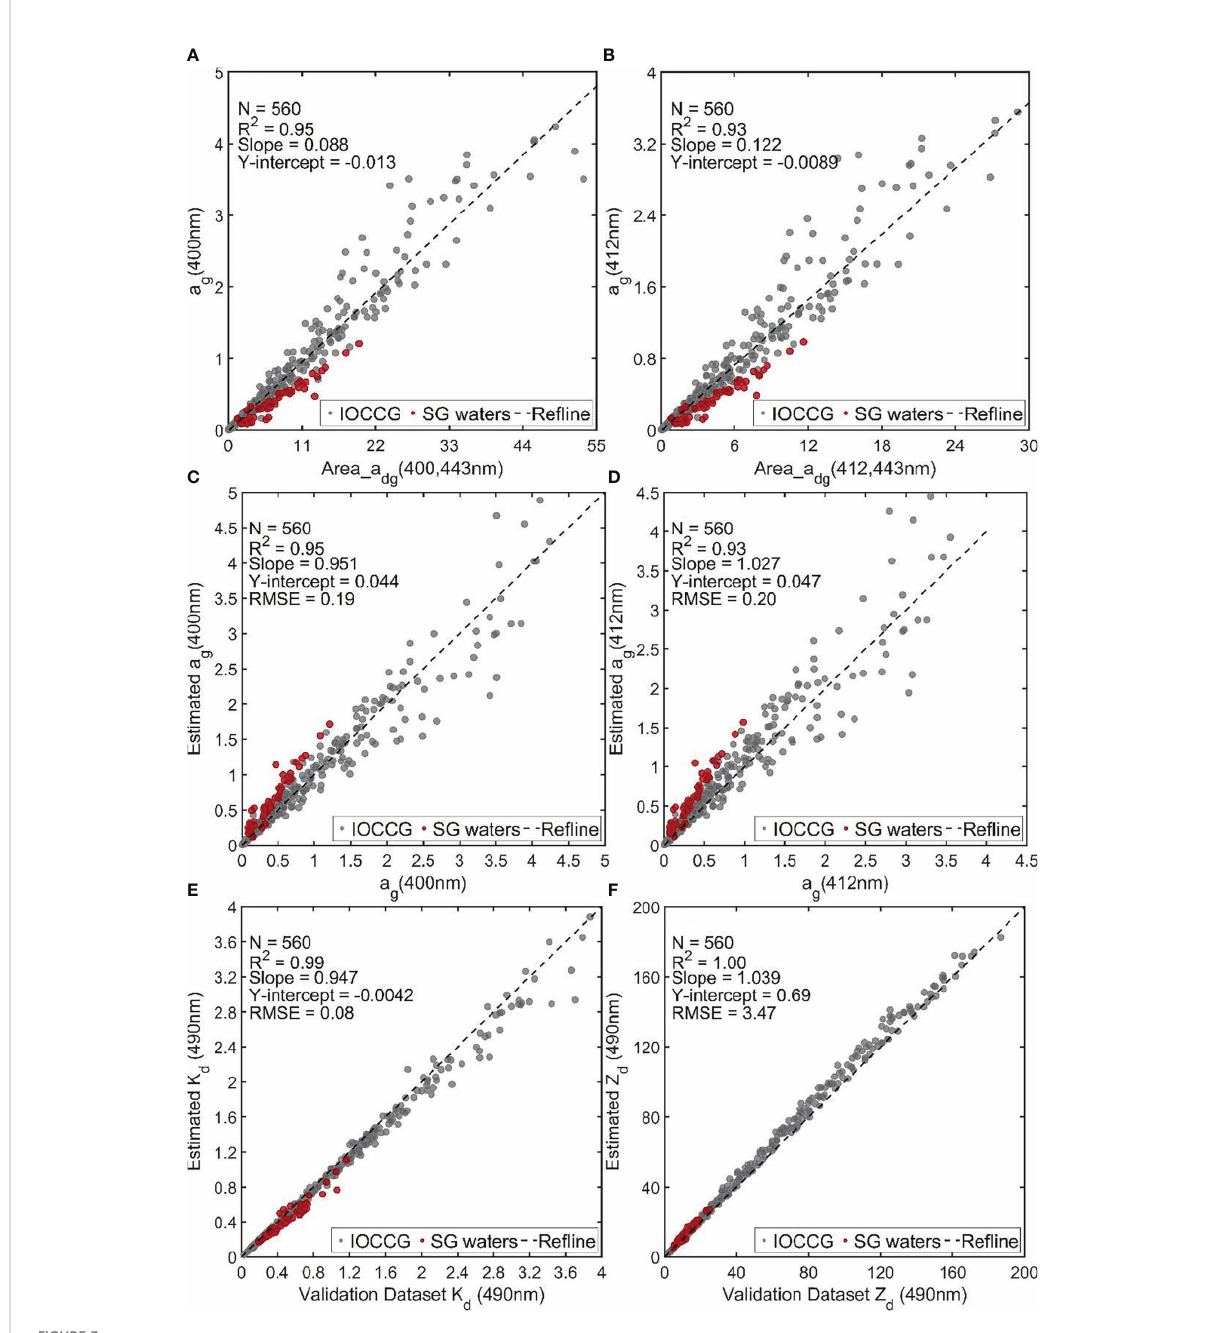
FIGURE 3 Comparison plots of (A) area under the a dg spectral curve and a g (400nm). (B) area under the a dg spectral curve and a g (412nm). (C) IOCCG+SG quanti fi ed and area-based estimations of a g (400nm). (D) IOCCG+SG quanti fi ed and area-based estimations of a g (412nm). (E) K d (490)